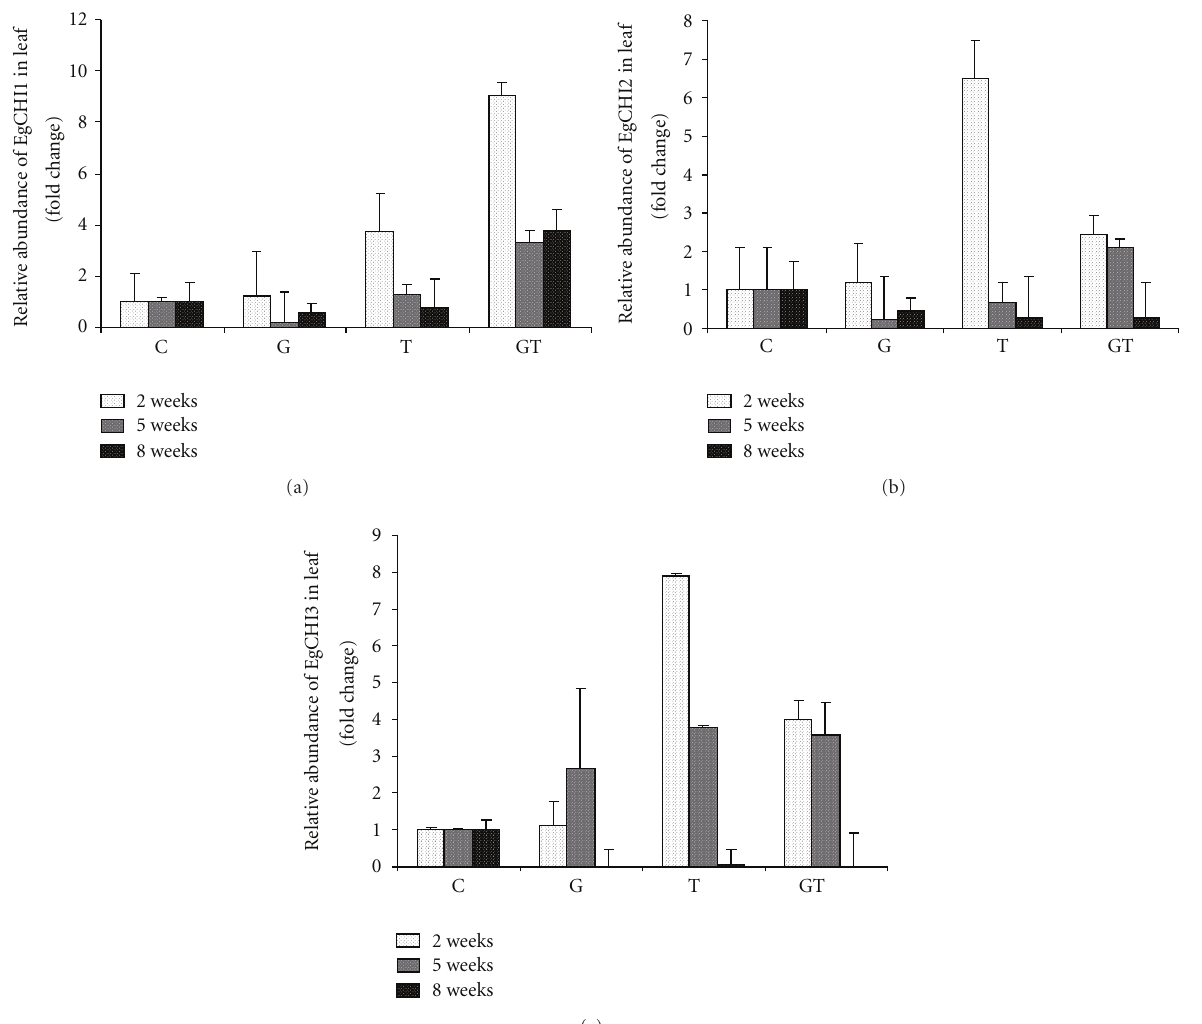
Figure 1: Relatives abundances of EgCHI1, EgCHI2, and EgCHI3 at various time points in oil palm leaf tissues, inoculated with G. boninense and T. harzianum either alone or together. To compare the levels of the transcripts among the treatments, the value of the control plant transcripts was set at 1 and the data for the treatments were then normalized to this value. Error bars indicate standard errors. The expression level was considered significant if the standard errors ≤ 0.5. C = Control, G = Ganoderma , T = Trichoderma , GT = Ganoderma +